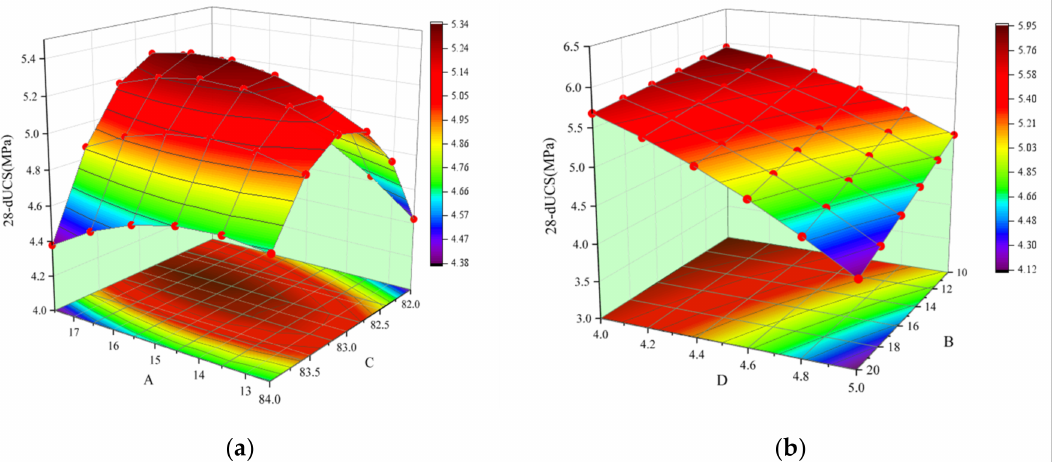
Figure 5. The interaction of AC and BD under 28-dUCS: ( a ) The effect of AC under 28-dUCS and ( b ) the effect of BD under 28-dUCS.